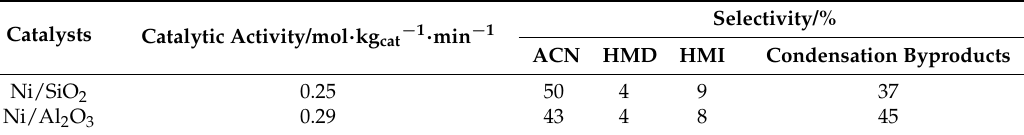
Table 2. Evaluation reaction result of Ni/SiO 2 and Ni/Al 2 O 3 .